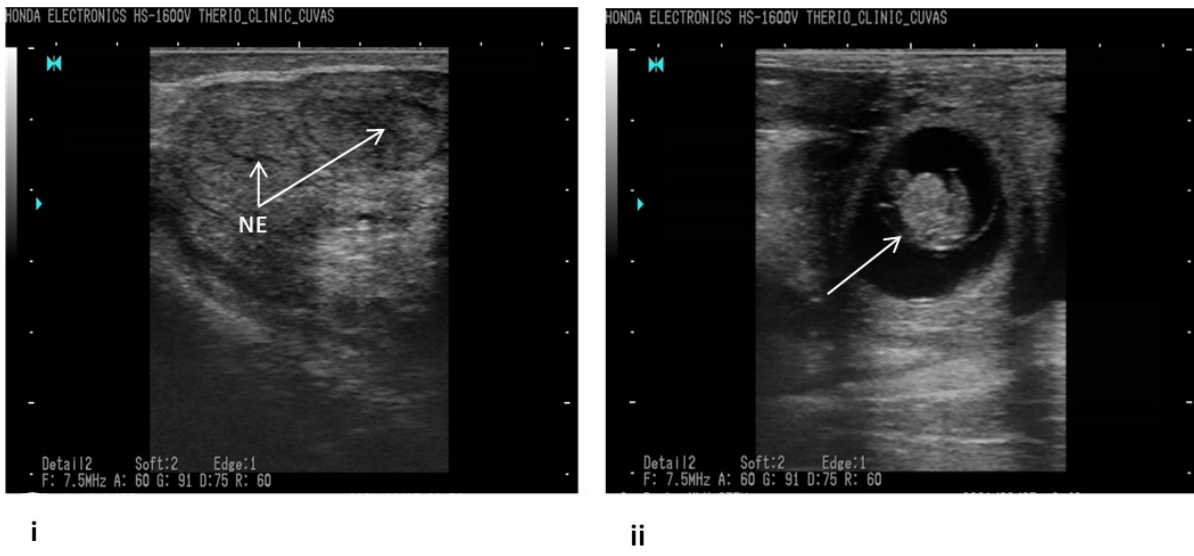
Figure 6. Ultrasonographic pictures after treatment. ( i ) NE = normal endometrium. ( ii ) Arrow indicates the fetus as a sign of established pregnancy.